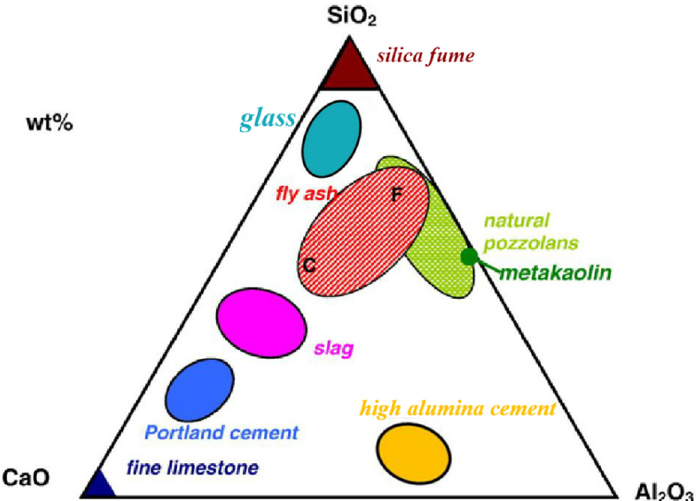
Figure 1. CaO–Al 2 O 3 –SiO 2 ternary diagram (wt % based) of common cementitious materials [4,5].